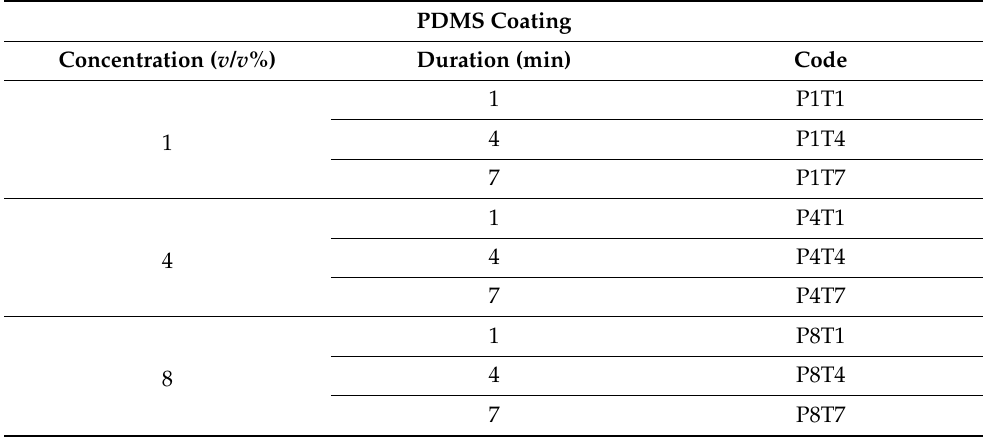
Table 2. Sample codes depending on concentrations and durations of polydimethylsiloxane (PDMS)